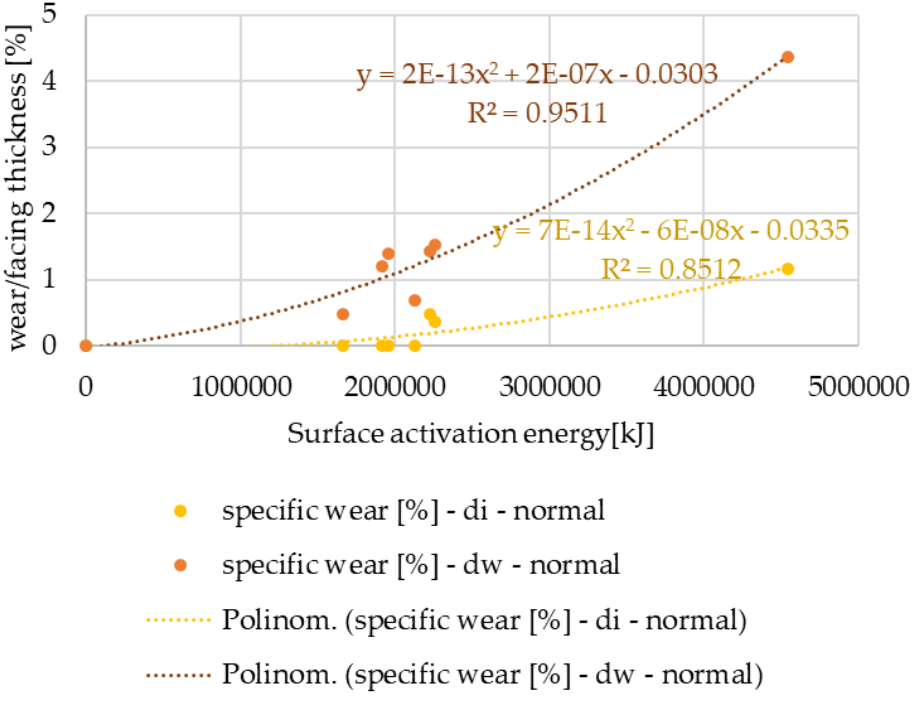
Figure 8. Wear % values versus facing thickness as a function of surface activation energy—normal use facings.